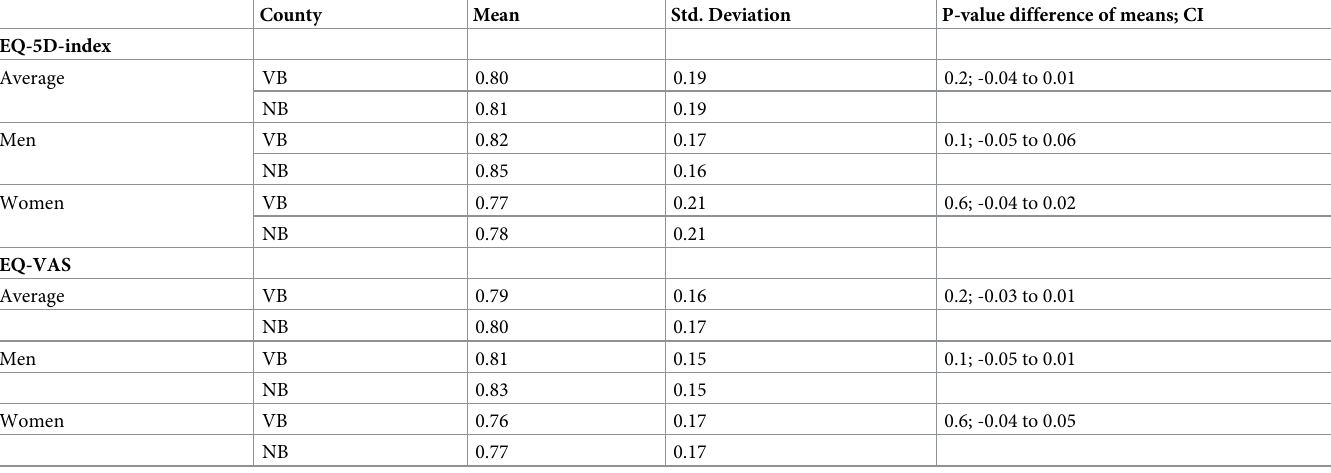
Table 3 presents the responses for the 3 levels of each dimension for each county. Both in VB and NB, participants reported more problems on the dimensions of pain/discomfort and anxi- ety/depression than on the other dimensions. Only small proportions, primarily in the pain/dis- comfort dimension, reported extreme problems. Similar proportions in NB and VB (33% respectively 32%) reported “no problems” on all the five dimensions. No significant differences between the counties in any of the dimensions were found, p-values ranging between 0.1 to 0.4.